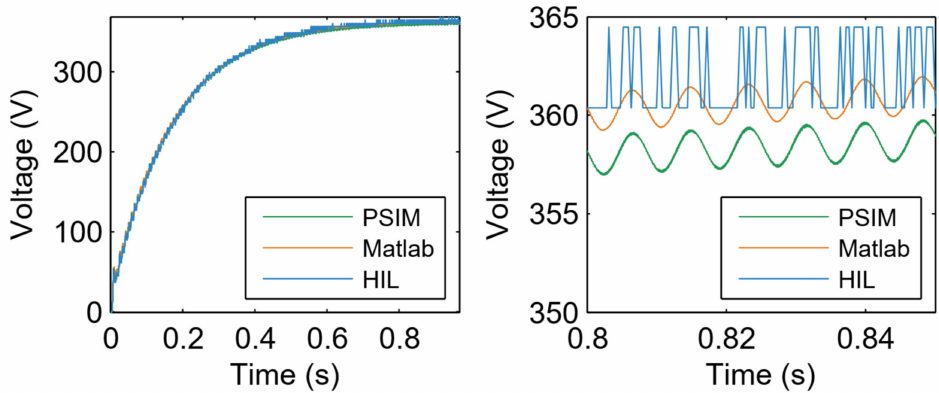
Figure 20. v dc response under open loop and rectifier mode